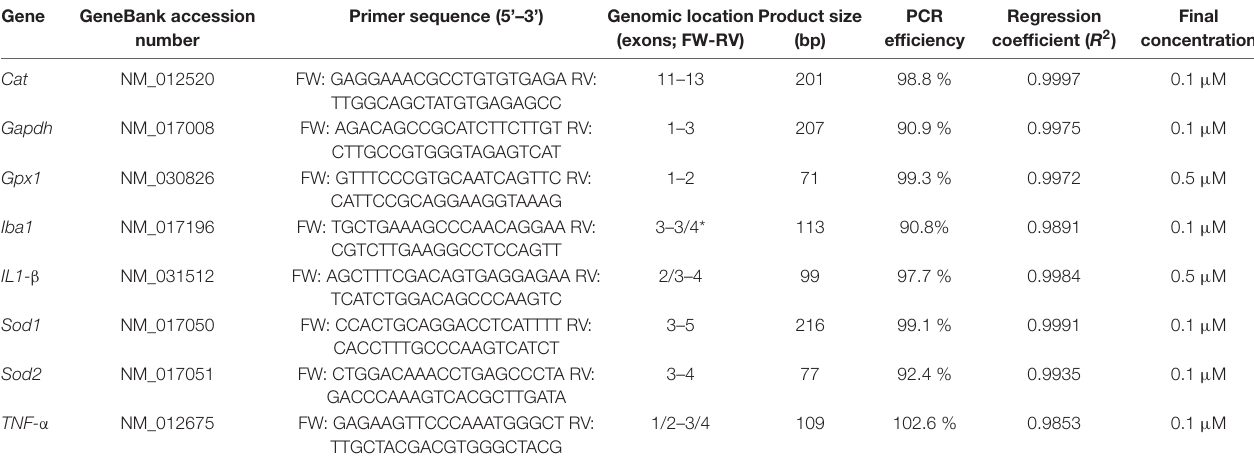
TABLE 2 | Oligonucleotides and qPCR